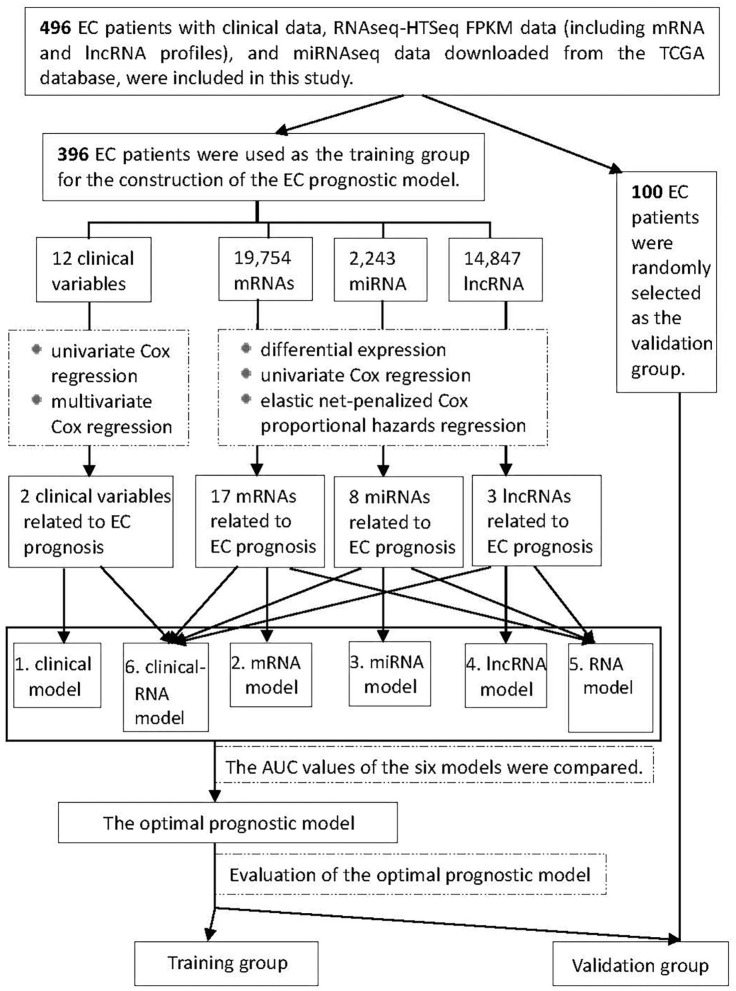
Flowchart of construction and evaluation of the EC prognostic model. AUC, the area under the receiver operating characteristic curve.